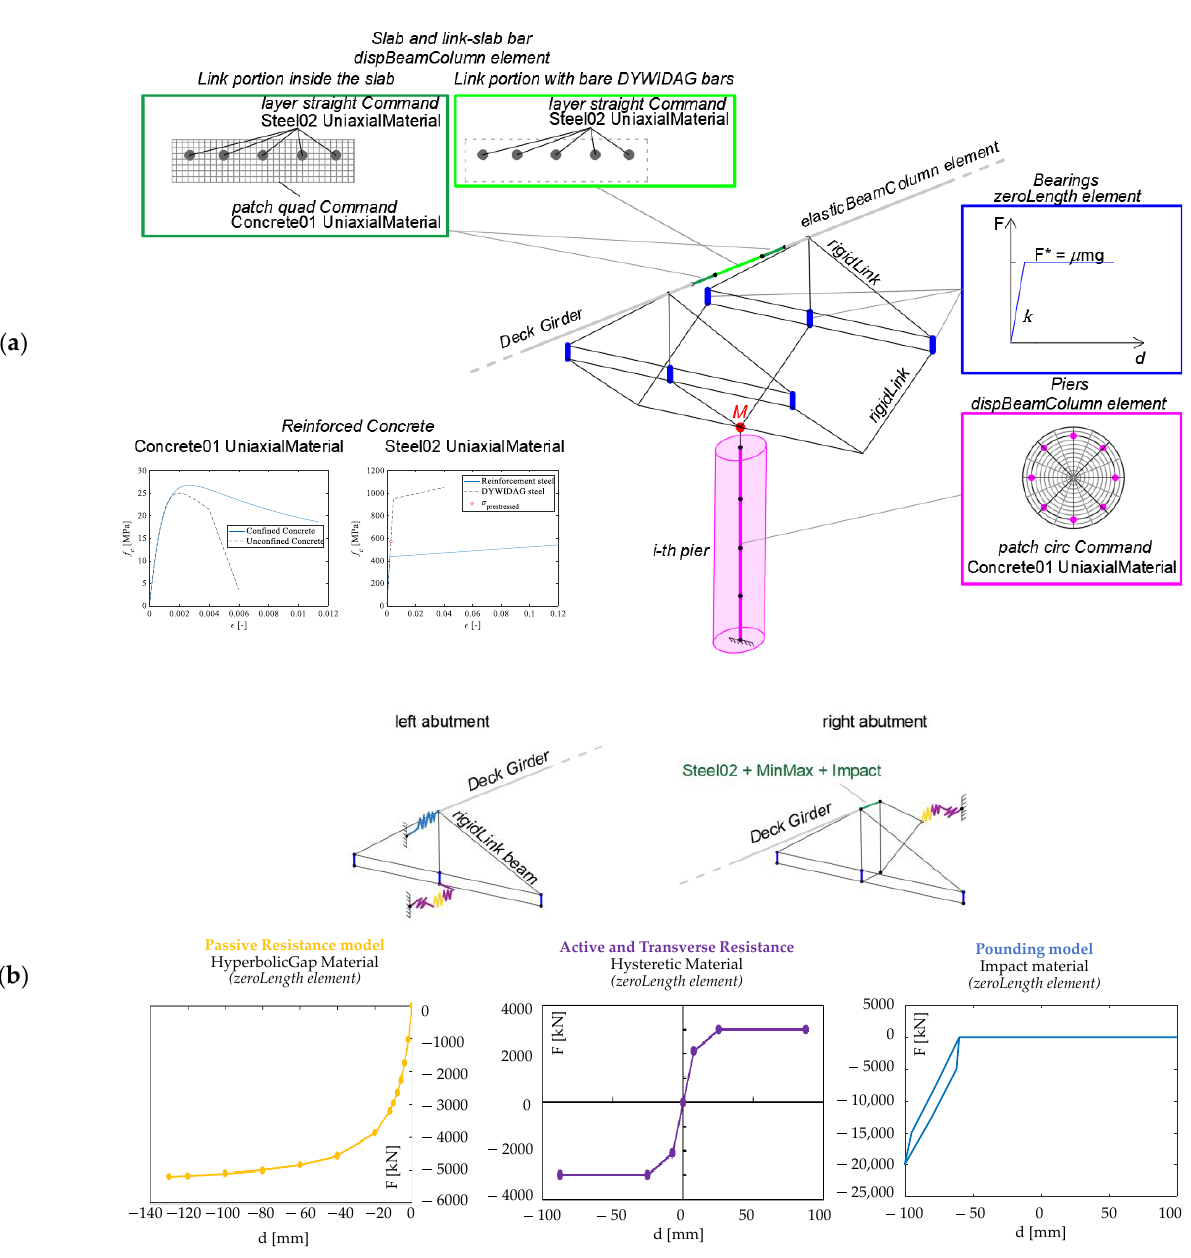
Figure 9. Details of the finite element model of the bridge: ( a ) deck, link slabs, bearings, and piers; ( b ) abutments and pounding.